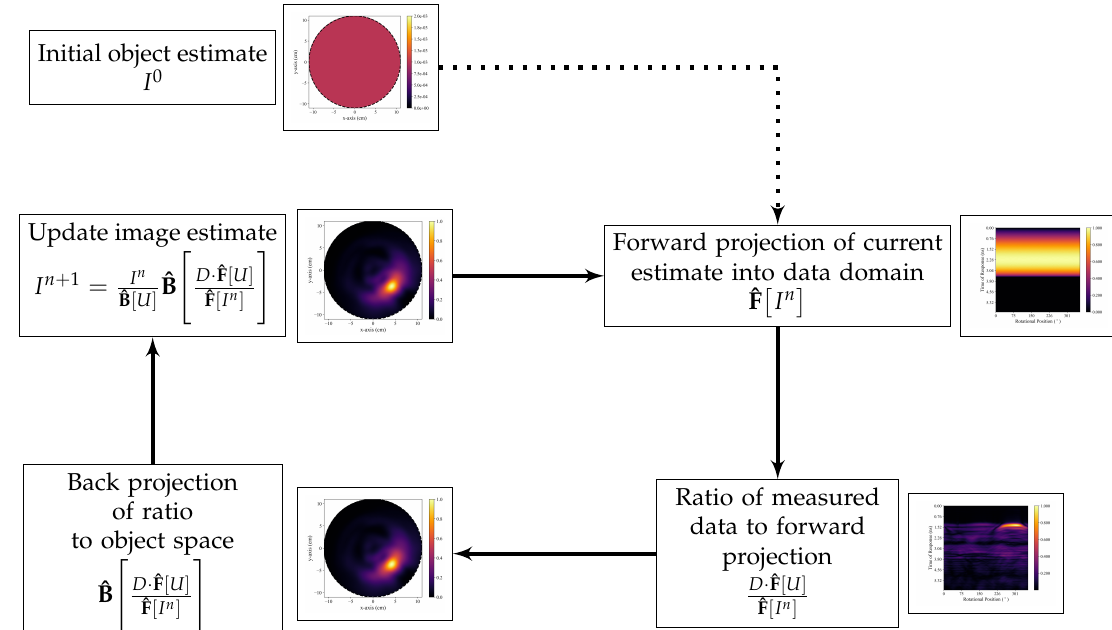
Figure 1. Flow chart of the functional form of the itDAS algorithm. The initial object estimate is forward-projected into the data domain, and the ratio between the measured data and this forward projection is determined. This ratio is then back-projected to the object space and the new image estimate is obtained by multiplying the previous image estimate by this back-projected